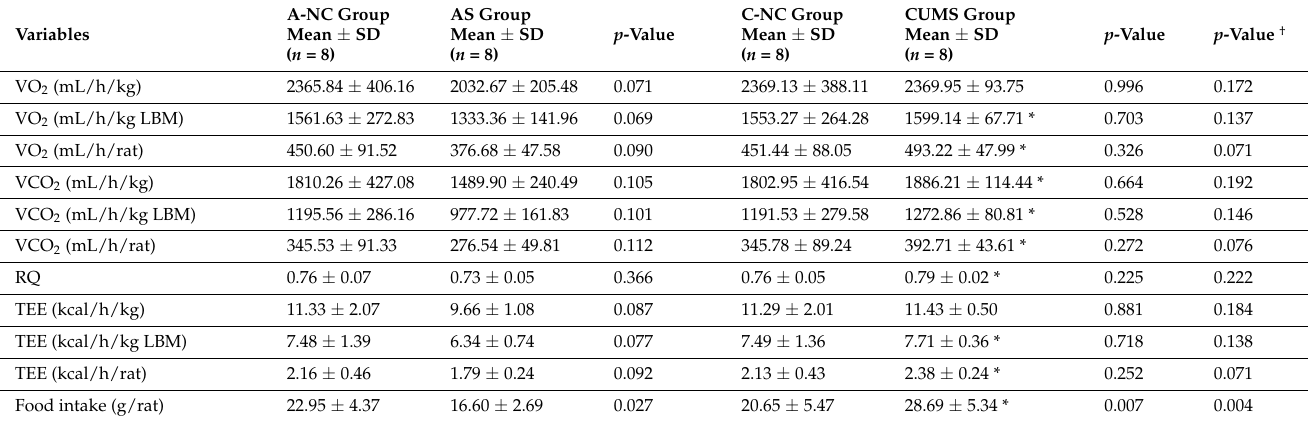
Table 3. Indirect calorimetry parameters of all studied groups.